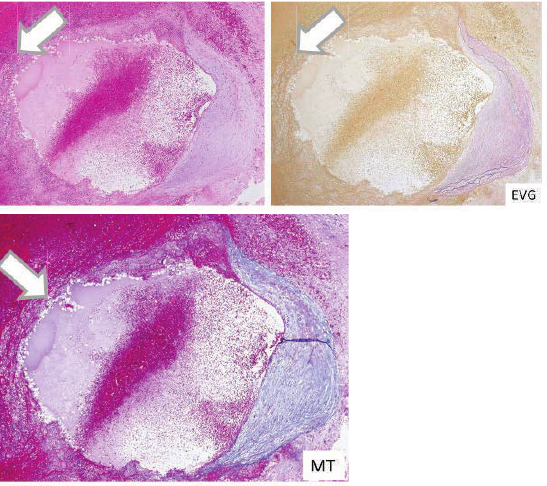
Figure 4. Histopathological specimen The rupture sites are attached by fresh thrombus, and showed no arterial wall (arrowhead). Only the small fragmented arterial wall, which is composed of thickended fibrocellular intima, was found